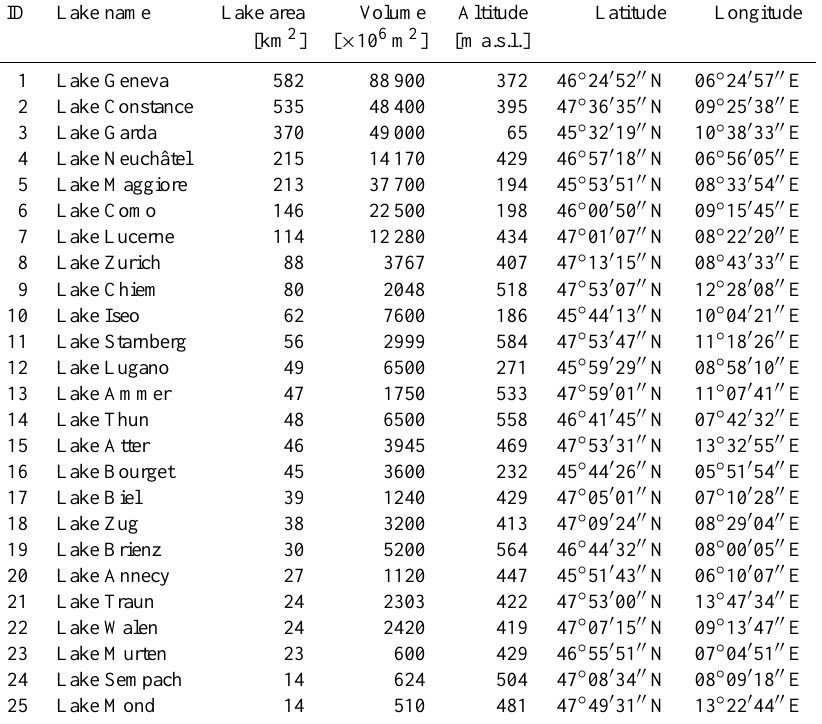
Table 1. List of European lakes in or near the Alps included in the data set showing their area, volume, and altitude according to Dokulil (2007), Bavarian Lakes, LfU Bayern (2014), Beiwl and Mühlemann (2008), and Swiss Lakes, BFS (2014). The numbers in the first column (ID) indicate the position of the lake in Fig. 1. The geographic co-ordinates indicate the position in the lake (centre of a 3 × 3 pixel matrix) for which the satellite data was extracted to create the proposed LSWT data